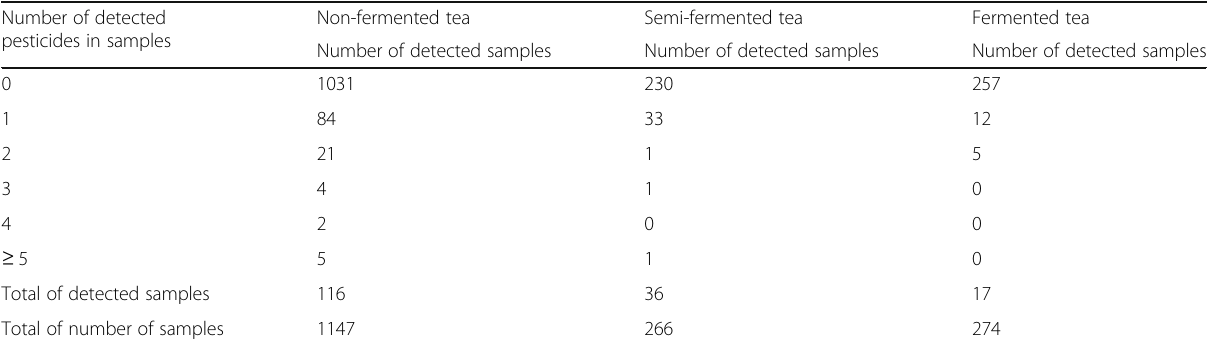
Table 3 Summary of residue data of OP pesticides detected on tea samples analysed in China Monitoring Program Number of detected pesticides in